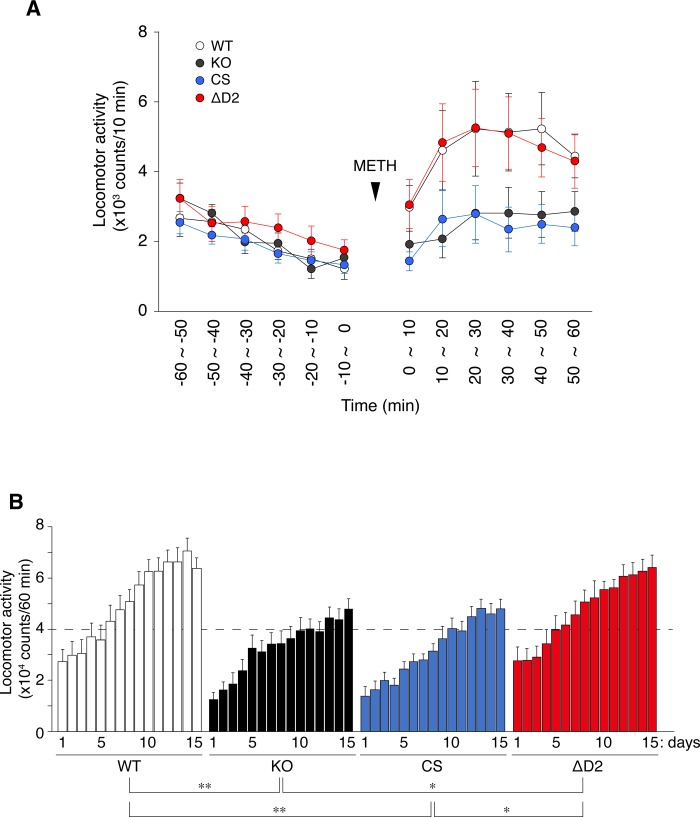
Locomotor response to METH administration.(A) Locomotor response to a single METH injection. After habituation to the ambulation chamber, mice were administered METH (1 mg/kg) and this was taken as time zero. Locomotor activity, as indexed by the number of sensor counts, was automatically recorded at 10-min intervals. The graph shows the mean values with standard errors (SE) on day 1 (n = 13 per group). (B) METH-induced locomotor sensitization. Mice were treated daily with METH (1 mg/kg), and locomotor activity was recorded for 60 min. The graph shows cumulated values for 60 min after the METH injection with the mean of sensor counts with SE on days 1 to 15 (n = 13 per group). There were significant effects of genotype (F(3, 48) = 7.151, P = 0.000) by a two-way mixed design ANOVA. *, P < 0.05; **, P < 0.01, significant difference between the indicated groups by the Bonferroni post-hoc test.